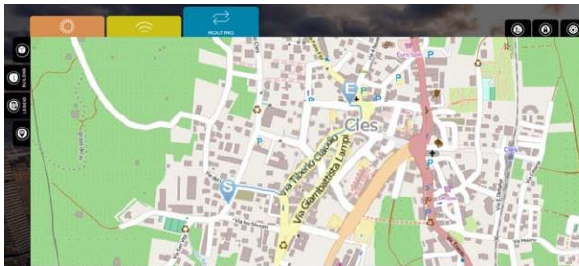
Figure 5. Platform with available information and routes of movement for senior